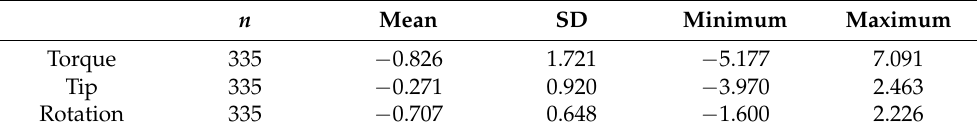
Table 2. Descriptive statistics of the angular deviation measurements ( ◦ ) of the STL digital